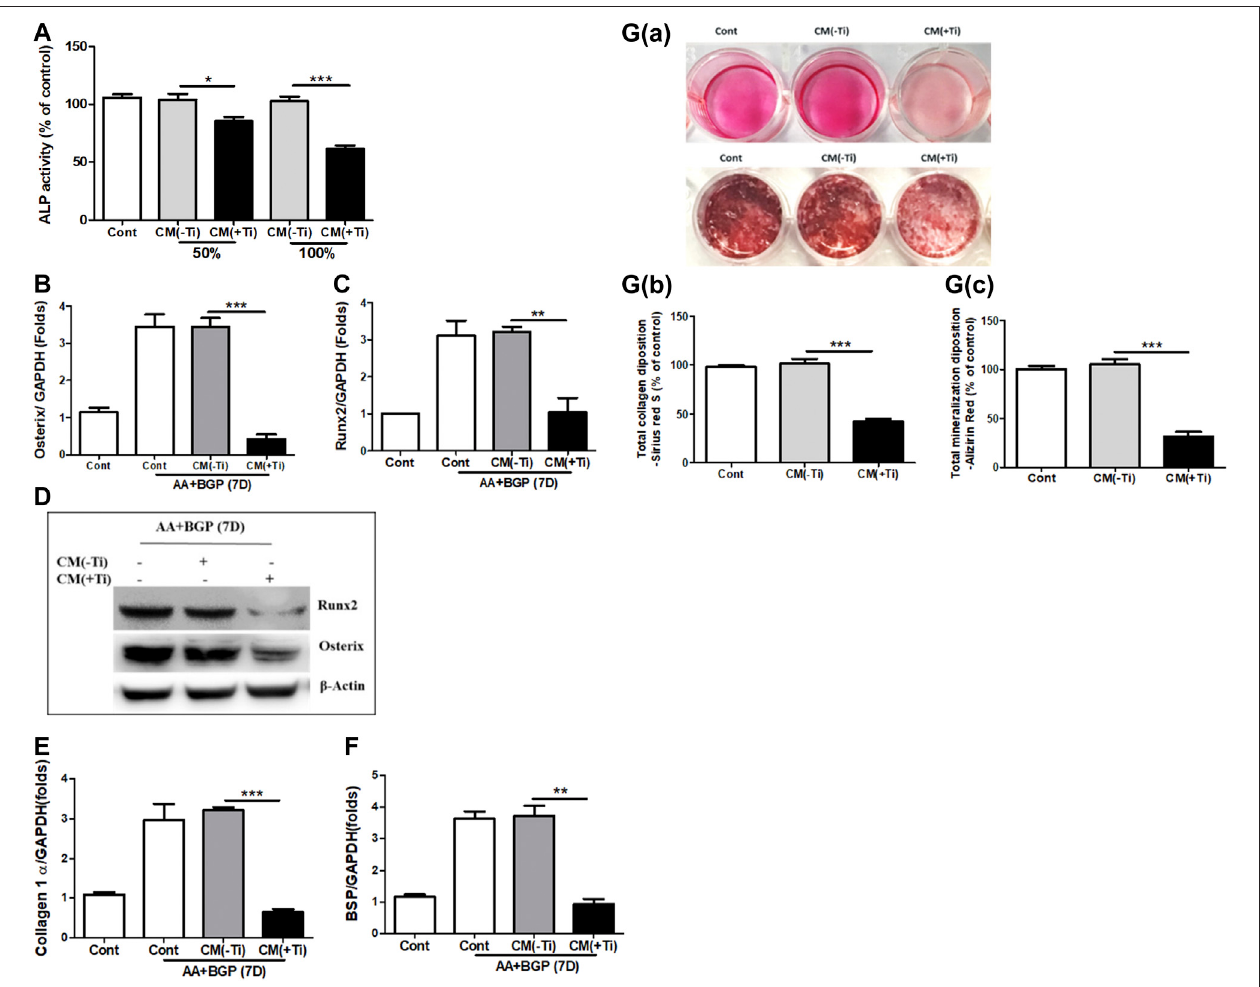
FIGURE3| TiCMsuppressedosteogenicmarkersofosteoblasts. (A) ALPactivitywasmeasuredwithtotallysatecollectedafter48 hoftreatmentwith50or100% Ti CM. SaOS-2 cells were grown under differentiation conditions as described in Materials and Methods for 7 days (D) and then treated with 100% Ti CM for 24 h. Transcriptsof (B) Osterix, (C) Runx2, (E) collagen1 α ,and (F) BSPwereanalyzedbyreal-timePCRwithextractedtotalcellularRNA.Theresultsshownarenormalizedto GAPDHlevels. (D) Proteinexpressions ofRunx2 andOsterix wereanalyzed bywesternblotting. β -Actinisusedasaloadingcontrol. (G(a)) Collagensynthesisand matrix mineralization were evaluated at day 14 by Sirius Red (upper lane) and Alizarin Red S (lower lane) staining (gross appearances), respectively, as described in Materials and Methods . (G(b,c)) Quantitative analysis of Sirius Red S and Alizarin Red S staining. Data are shown as mean ± SD. Similar results were obtained in three independent experiments. * p < 0.05, ** p < 0.01, and *** p <